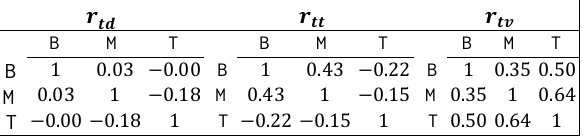
Table 4. Spatial correlation coefficients of each travel indicator (B=bus, M= metro, T= taxi)